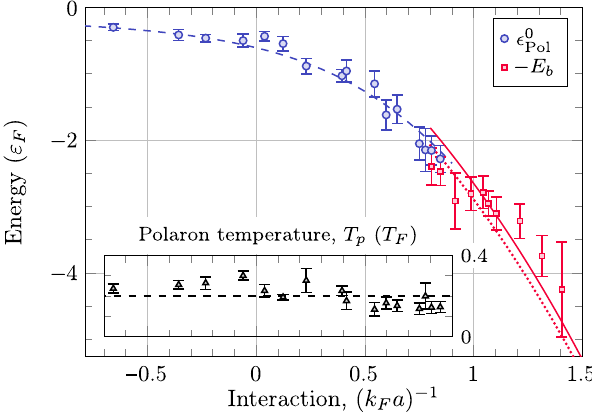
FIG. 4. Measured polaron and pairs binding energies. The polaron energies ϵ 0 (blue circles) are obtained using Eq. (17) pol from the position of the spectral peak ω 0 . The theoretical prediction obtained from the variational Ansatz Eq. (2) is shown as a dashed blue line. The E b parameter (red squares) is determined by fitting the Raman spectra with Eq. (6). For ð k F a Þ − 1 > 0 . 5 , it is in good agreement with the energy obtained from the simple molecular Ansatz Eq. (3) (solid red line). The dotted red line shows the result of an improved molecular Ansatz [38]. Note that the theoretical polaron and molecule energies are averaged over the harmonic trap (see Appendix A), and as a result, they cross at a ð k F a Þ − 1 slightly lower than the predicted polaron-to-molecule transition in a homogeneous gas. Inset: extracted polaron temperatures. The approximate majority tem- perature is denoted by the dashed